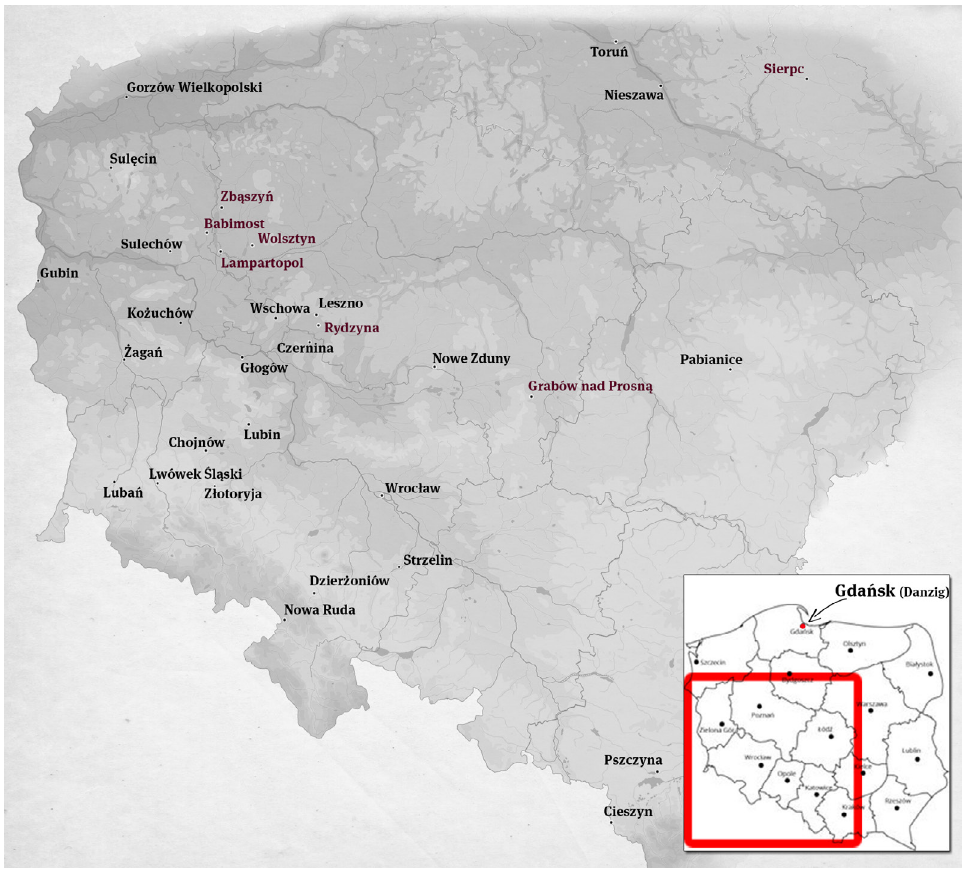
Figure 1. Map showing places of origin of all cloth seals known from